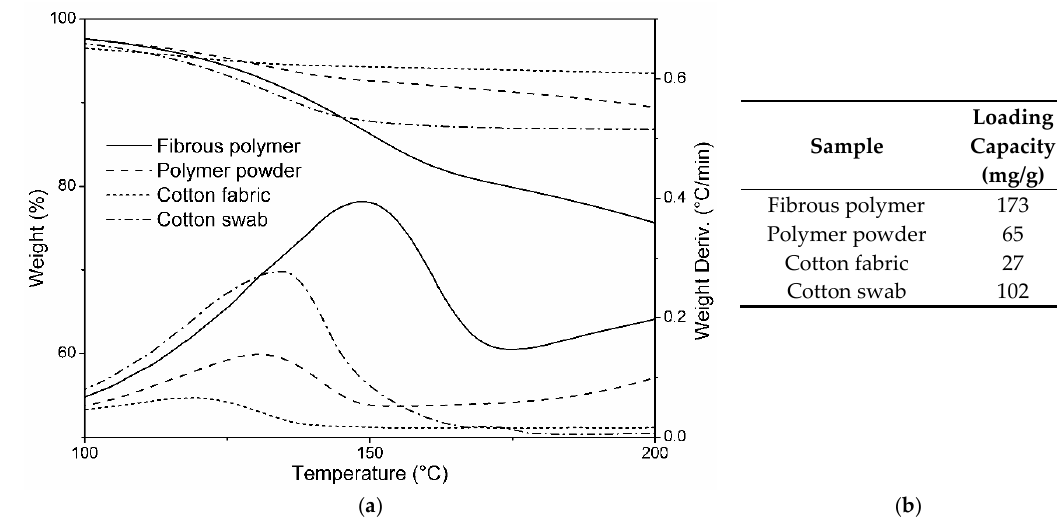
Figure 4. ( a ) Thermogravimetric analysis (TGA) and ( b ) DEET loading capacity of beta-cyclodextrin ( β CD)-based fibrous polymer (Fibrous polymer), the same polymer but with powder morphology (Polymer powder), a pure cotton fabric (Cotton fabric), and a cotton swab (Cotton